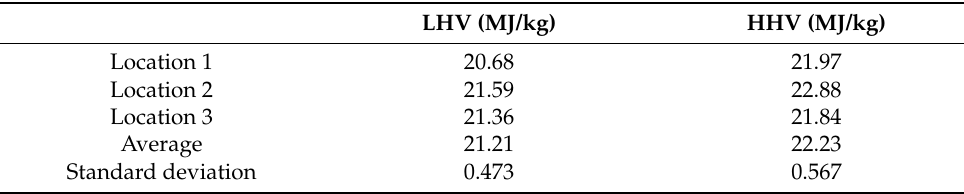
Table 3. Low and high heating value of A. altissima .